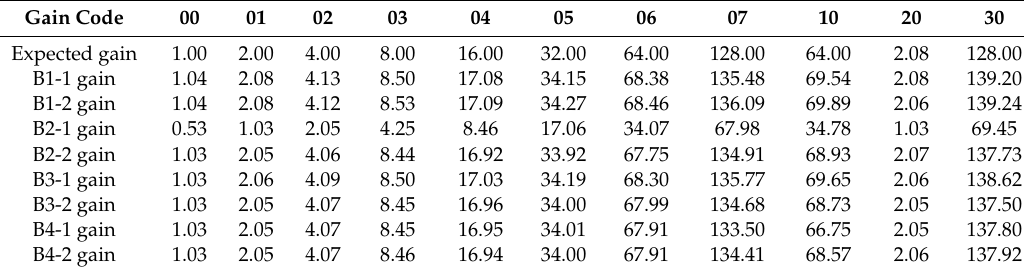
Figure 10. Normalized passband characteristics of the analog processing channels. Table 2. Gain table of the analog processing channels.